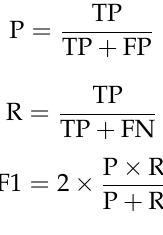
Table 4 analyzes the DGPolarNet performances through true-positive (TP), false- negative (FN), and true-negative (TN) samples of the semantic segmentation results. Ac- cordingly, the precision (P), recall (R), and F1 scores were calculated by using Equation (10) to evaluate the semantic segmentation